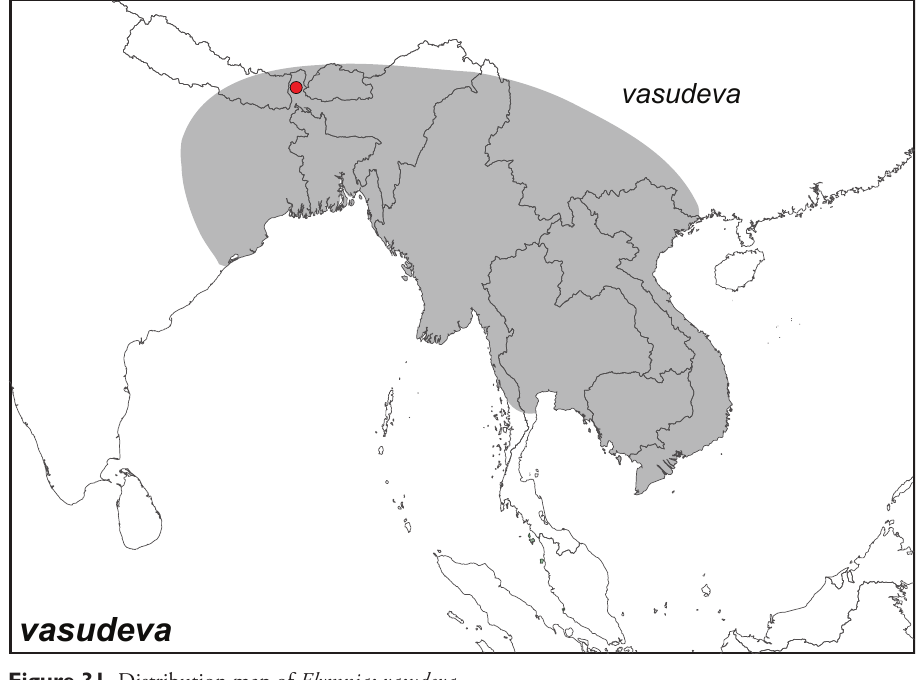
Figure 31. Distribution map of Elymnias vasudeva.